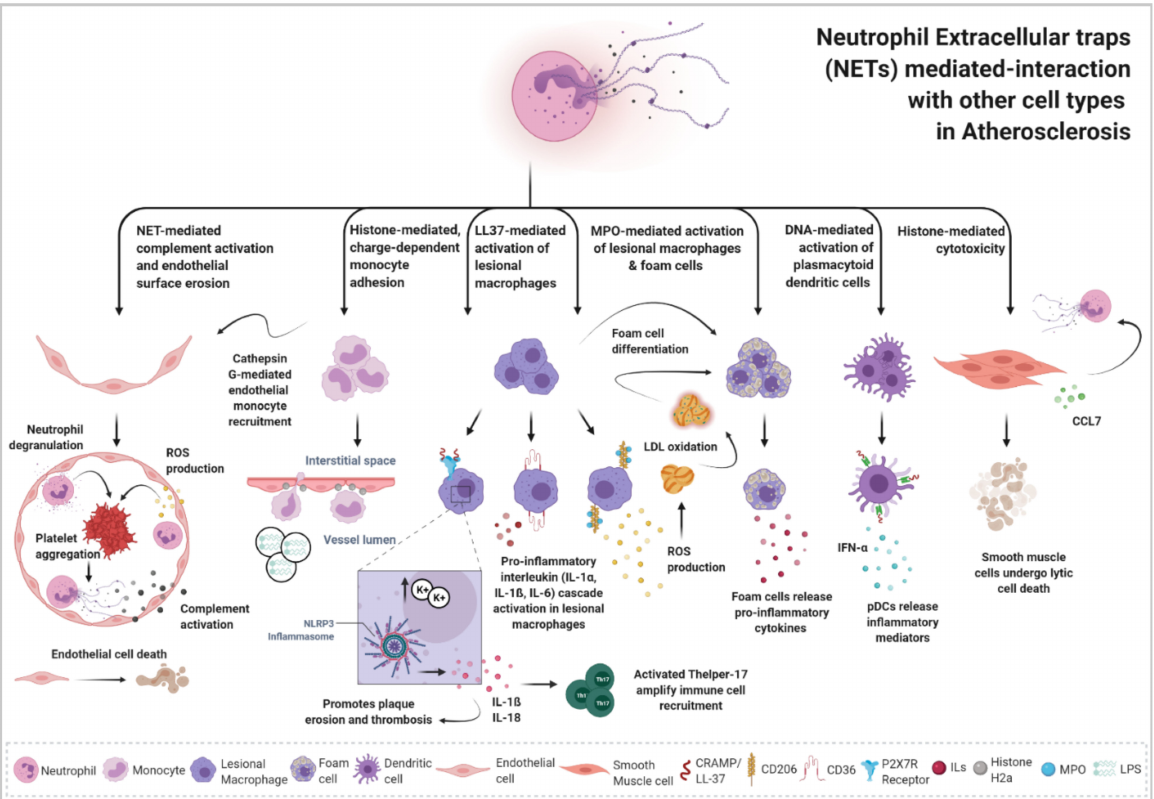
Figure 1. Neutrophil extracellular traps-mediated interaction with different cell populations in atherosclerosis. The highly activated neutrophil during atherogenesis—after the lesion initiates at sites of disturbed blood flow and enhanced shear stress—finds there the ideal inflammatory-prone scenario to undergo NETosis. Neutrophil extracellular traps (NETs) are able to mediate different responses in the diverse immune and structural cell populations that co-exist within atherosclerotic lesions and so they can drive lesion progression. NETs sustain a chronic inflammatory recruitment of monocytes, monocyte- derived macrophages and lymphocytes by either paving the way for monocyte recruitment through histone-mediated and charge-dependent monocyte adhesion mechanisms or by triggering the NLRP3 inflammasome activation in macrophages, which through the release of the pro-inflammatory cytokine IL-1ß, can activate T-helper 17 lymphocytes and amplify immune cell recruitment in the artery wall. NETs can also cast tissue damage in the arterial wall towards endothelial and smooth muscle cells due to some recently described NET-mediated cytotoxicity mechanisms. Through complement activation, NETs induce endothelial erosion in the tunica intima, and through a histone-mediated cytotoxicity mechanism, NETs can directly mediate the apoptosis of smooth muscle cells in the tunica intima and the tunica media. Moreover, NET components such as the myeloperoxidase (MPO) granule protein, or the cathelicidin-related antimicrobial peptide (CRAMP)—LL-37 in humans—can bind to different macrophage receptors, such as the macrophage mannose receptor CD206 or the macrophage scavenger receptor CD36 and increase oxidative stress. Reactive oxygen species (ROS) production triggers the oxidation of deposited low-density lipoprotein (LDL) and cholesterol which, in turn, promotes further NETosis, triggers foam cell differentiation in lesional macrophages and ultimately contributes to advance lesion progression and development. Created with